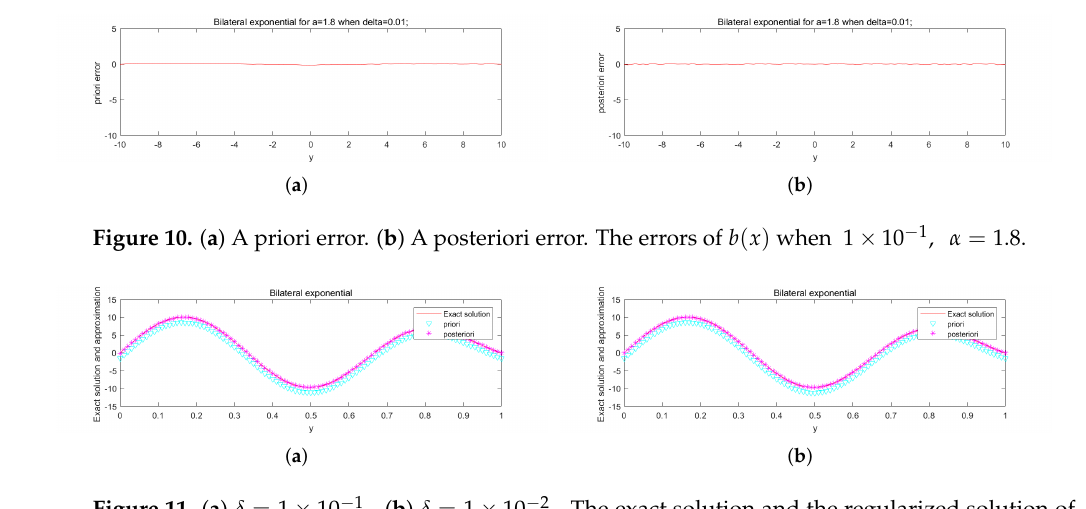
Figure 11. ( a ) δ = 1 × 10 − 1 . ( b ) δ = 1 × 10 − 2 . The exact solution and the regularized solution of f ( x ) when α =